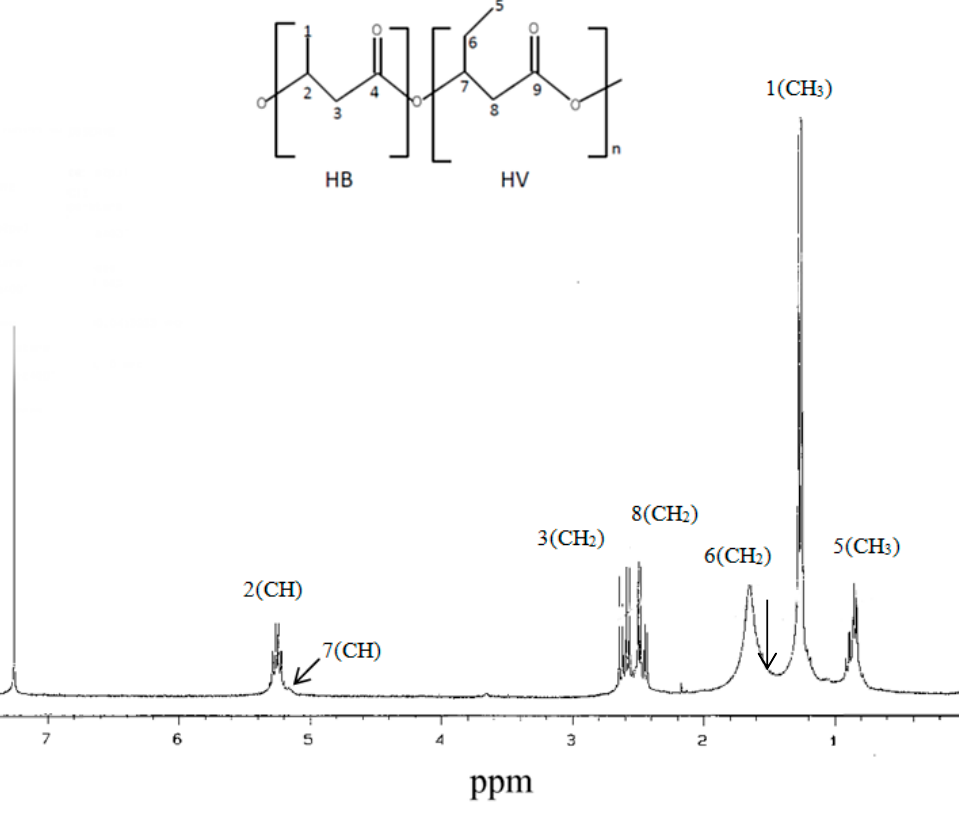
Figure 5. 1 H-NMR of PHAs produced by C. necator from TSB with the PP-2 sample as an additional carbon